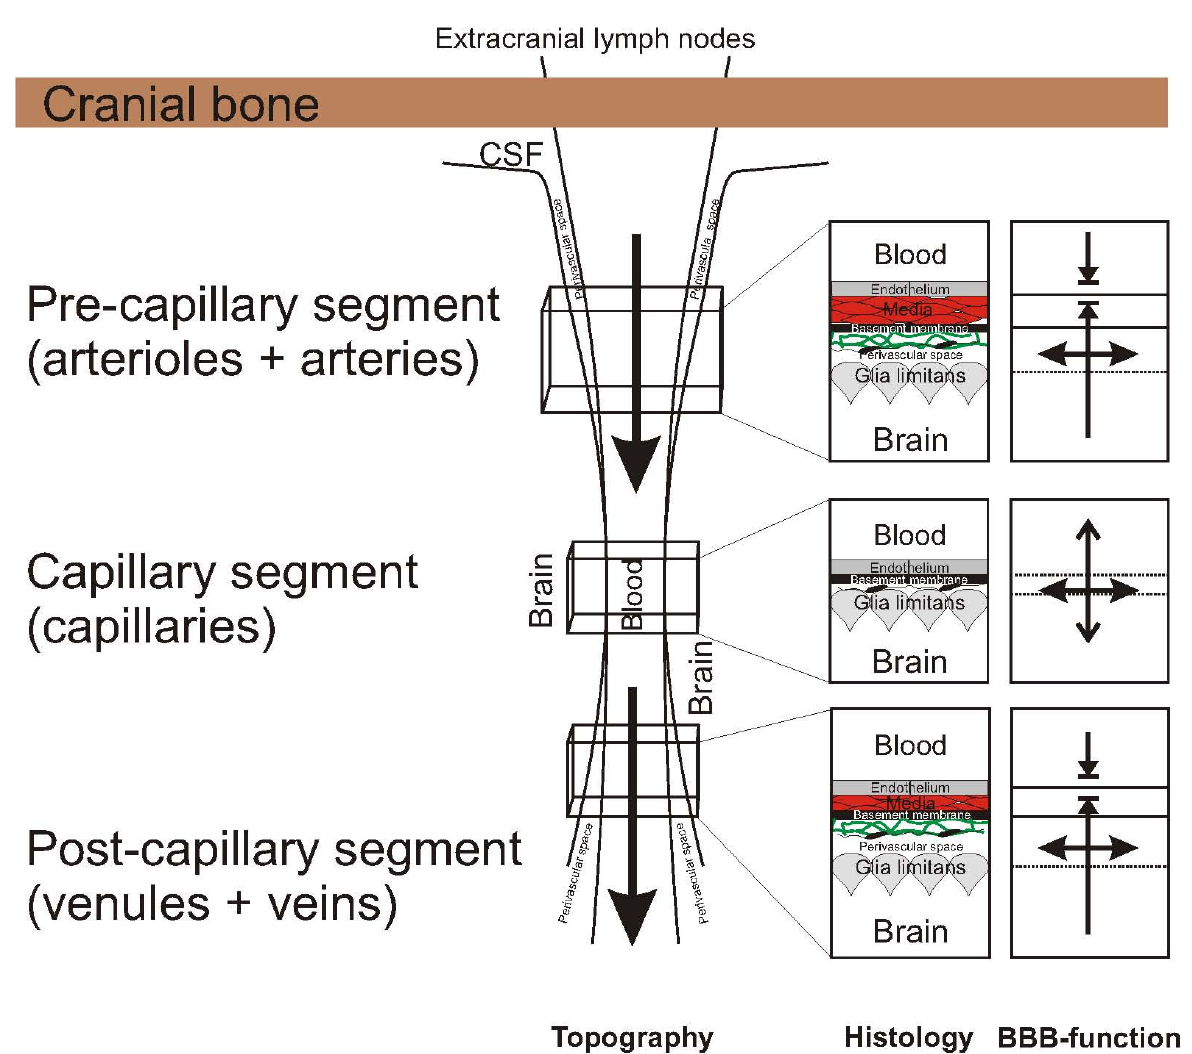
FIGURE 1 . Schematic representation of the three segments of the BBB. Topographically , the precapillary segment of the BBB is associated with the intracerebral arteries and arterioles, whereas the postcapillary segment is associated with intracerebral venules and veins. The capillary BBB segment represents all capillaries of the brain parenchyma. Arteries and veins enter the brain from the extracranial site. As demonstrated in the schematic representation of the histology , the perivascular space is significant in the pre- and postcapillary segment, whereas it is negligible in the capillary one. Functionally , the endothelium of the pre- and postcapillary segments does not allow significant transport of fluid or proteins from the blood into the perivascular space and the brain parenchyma, or vice versa. Even the high arterial blood pressure in the precapillary segment does not lead to plasma leakage under normal conditions. However, extracellular fluid and proteins can be cleared into the perivascular space and into vascular basement membranes from where it is drained into the CSF or to the extracranial cervical lymph